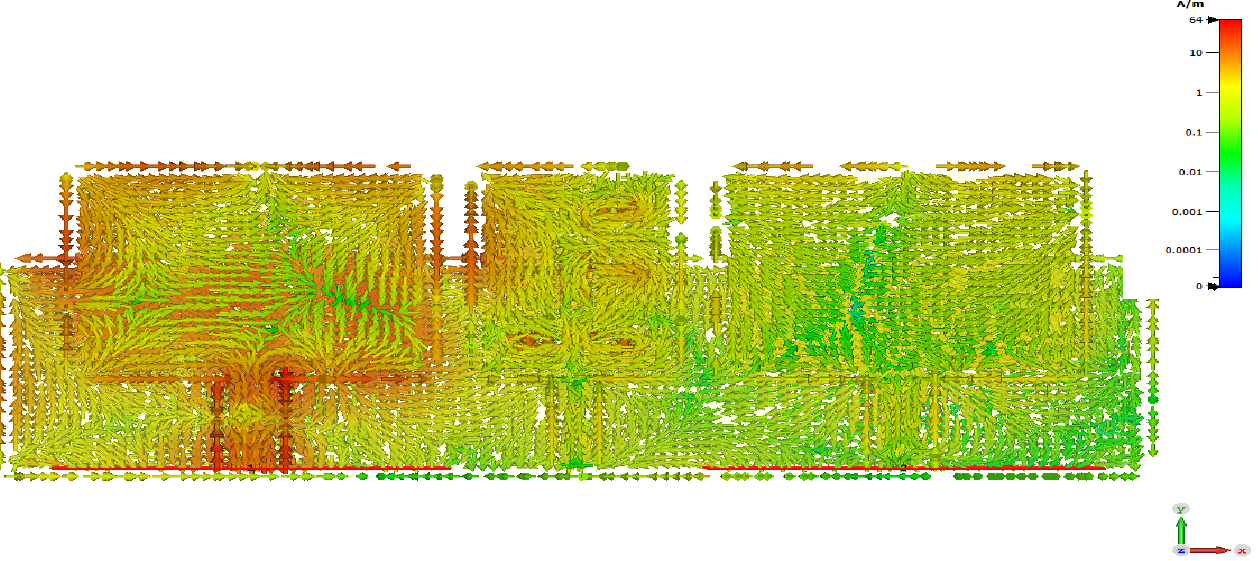
Figure 5. Current density of 2 1 × microstrip patch antenna array with MTM-DS. Figure 6a shows the simulated and measurements parameters of the MTM-DS an- tenna array. The isolation is − 27.5 dB and the operating frequency is from 9.3:10.5 GHz with a bandwidth equal to 1.2 GHz. Figure 6b shows the fabricated array of antenna.